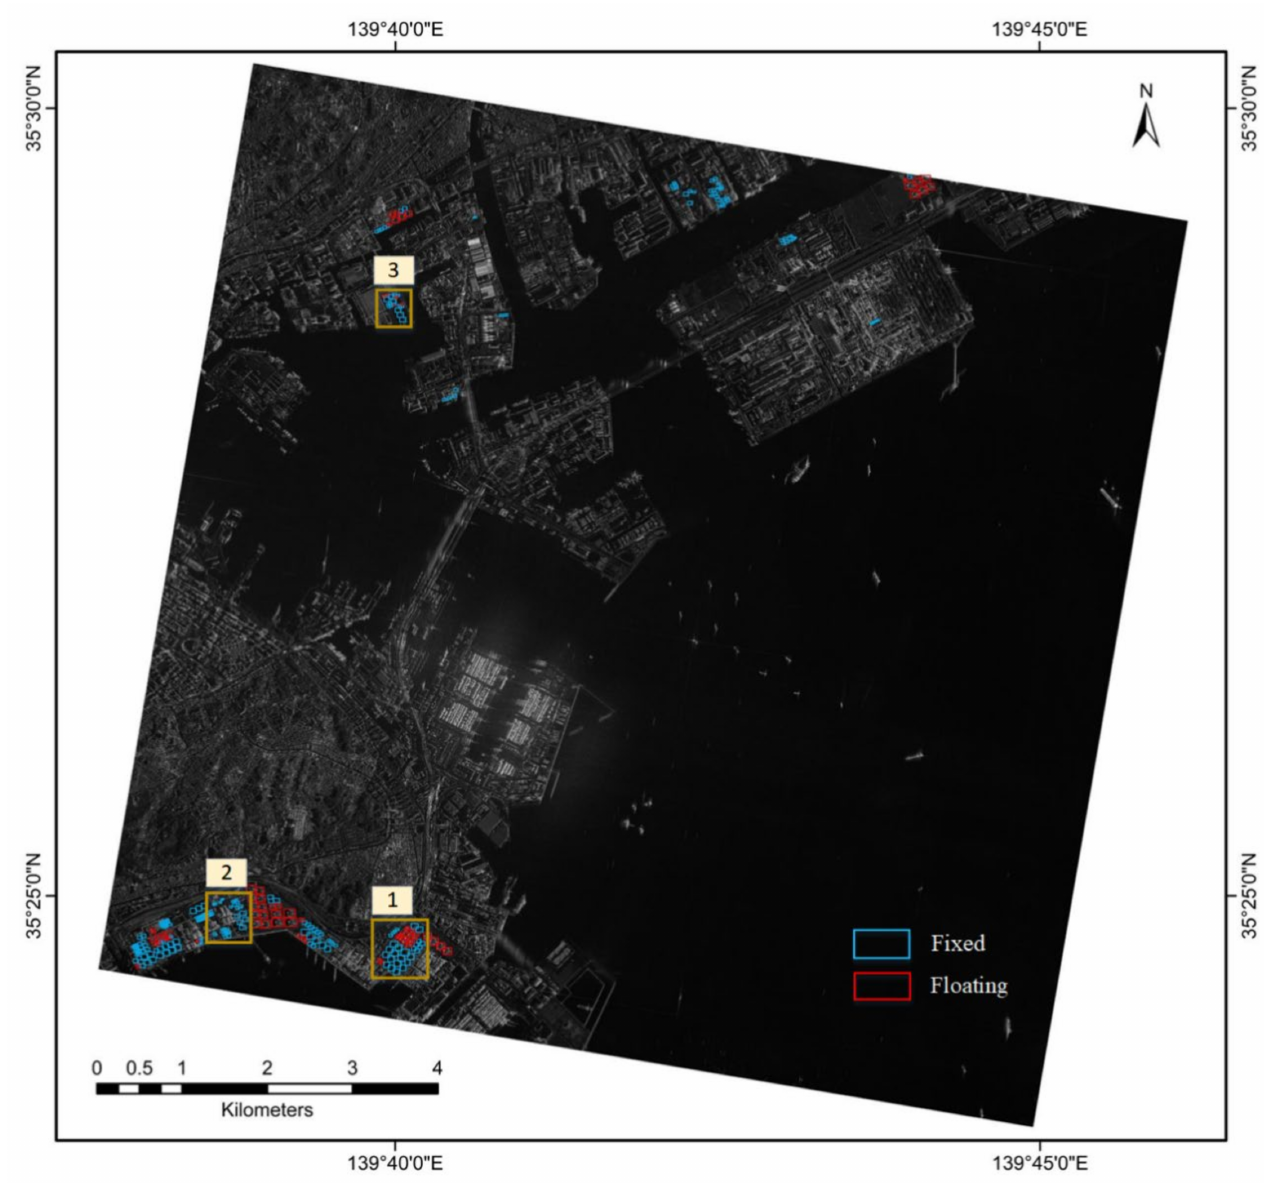
Figure 8. The detection and classification result in a large-scale SAR image of Yokohama via Yolox-TR. Boxes numbered 1–3 are three densely arranged regions selected to further compare the detection results of the original YOLOX and the redesigned model